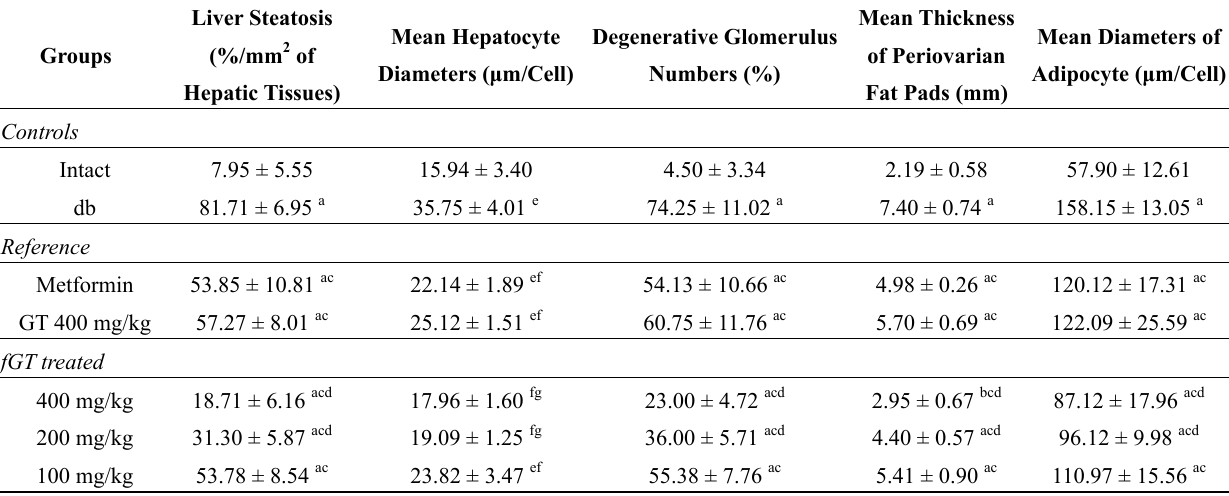
Table 6. Changes on histopathology-histomorphometry of the liver, kidney and periovarian fat pads in intact normoglycemic and db/db